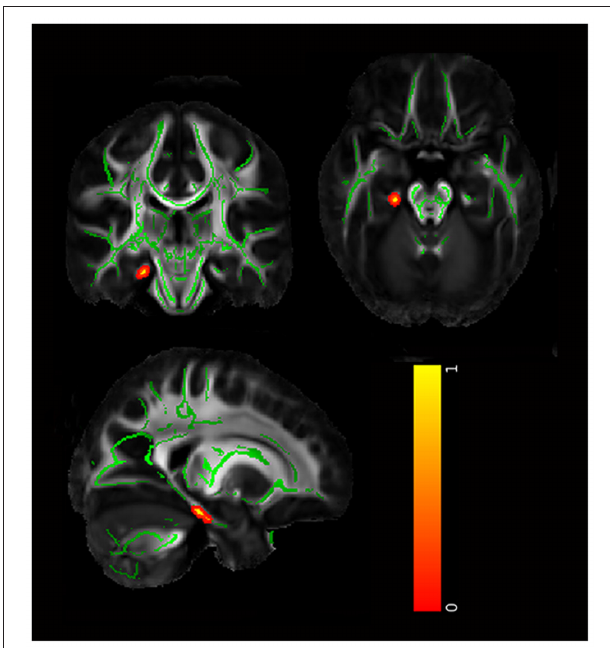
FIGURE 3 | The significant differences in attempters compared with non-attempters (uncorrected p < 0.005). The mean FA skeleton is shown in green, and regions with higher FA values are shown in red. The color bar provides 1- p